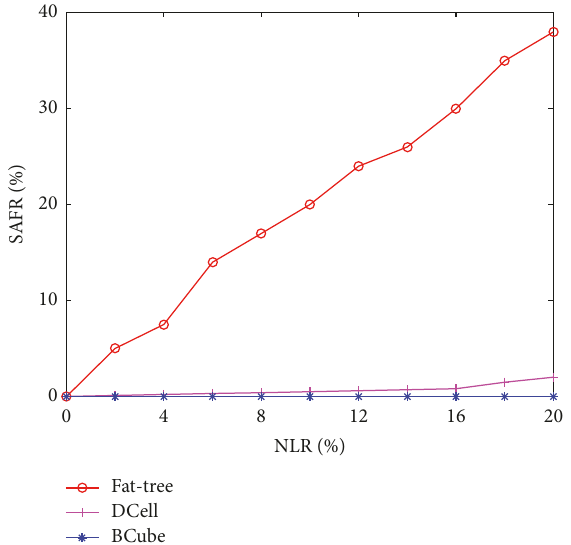
Figure 1: The relationship between network blocking rate (NBR) and scheduling algorithm fault rate (SAFR) in different